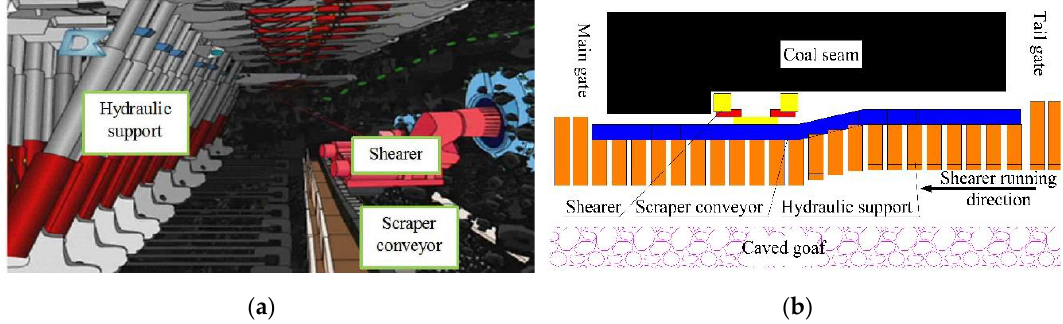
Figure 1. Equipment layout of a typical fully mechanized mining face; ( a ) front view; ( b ) top view.